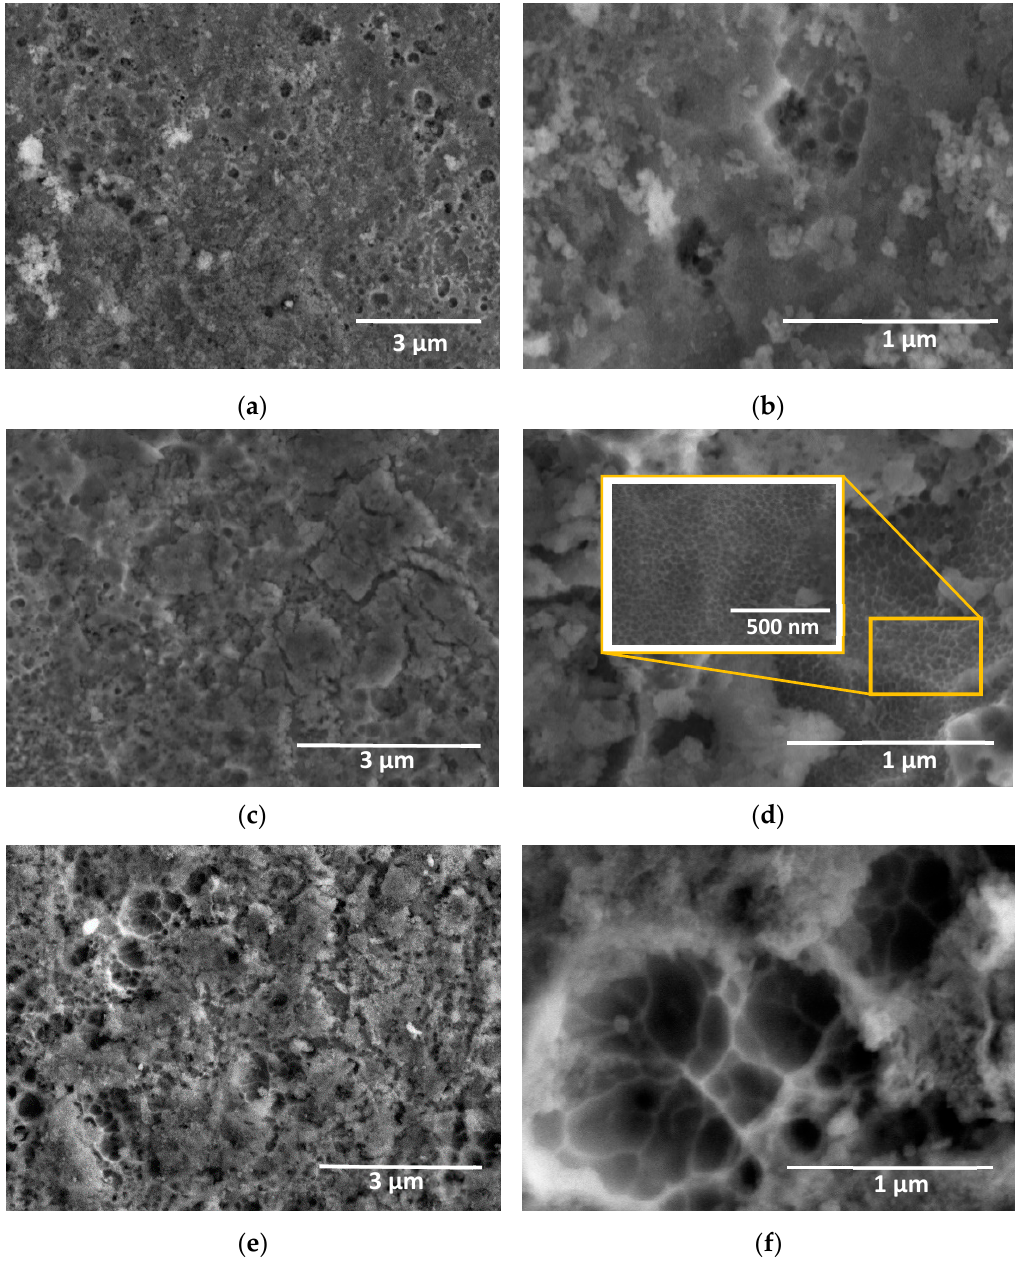
Figure 8. SEM images of the anodic layers grown in a glycerol, 0.05 M Na 2 SiO 3 with H 2 O concentra- tion of ( a , b ) 1.0, ( c , d ) 1.7, and ( e , f ) 2.5 vol% for 6 min at 20 mA/cm 2 . Table 2. EDS analysis of the 304L SS anodic layers from Figure 8.